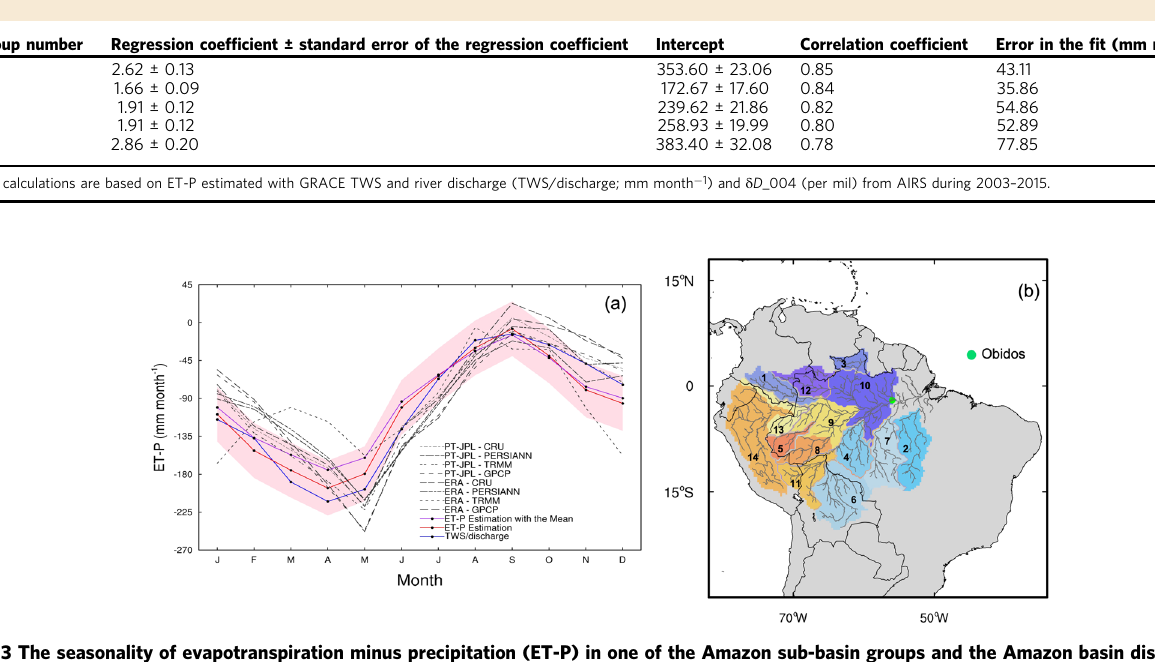
Table 1 The regression coef fi cient and standard error of the regression coef fi cient, intercept, correlation coef fi cient, and the root-mean square (RMS) error in the fi t (mm month − 1 ) between ET-P and δ D _004 in the 5 river basin groups: Group 1 (basins 3, 10 and 12), Group 2 (basins 1, 13, and 14), Group 3 (basins 5, 8, and 9), Group 4 (basins 4, 6, and 11), and Group 5 (basins 2 and 7).